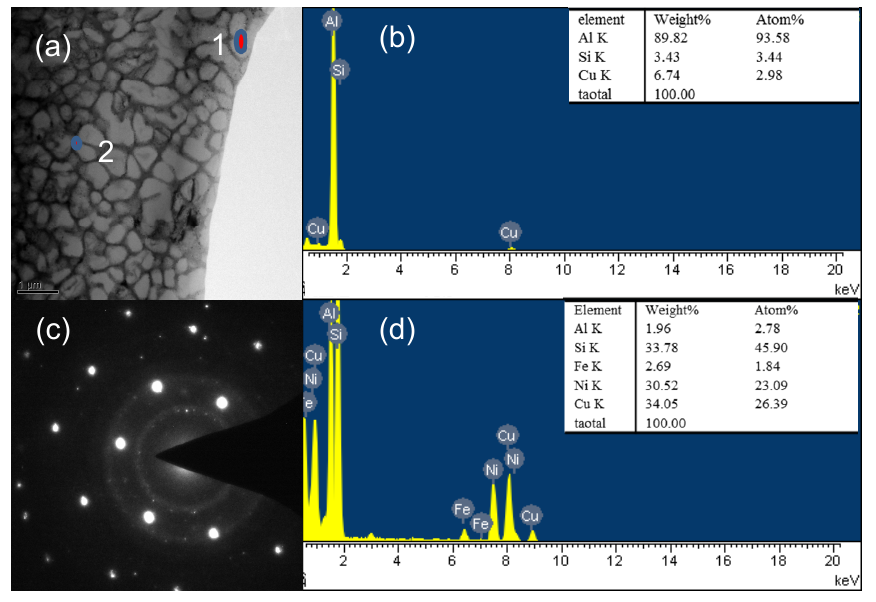
Figure 7. TEM analysis with the cooling rate 1.5 × 10 5 °C/s.